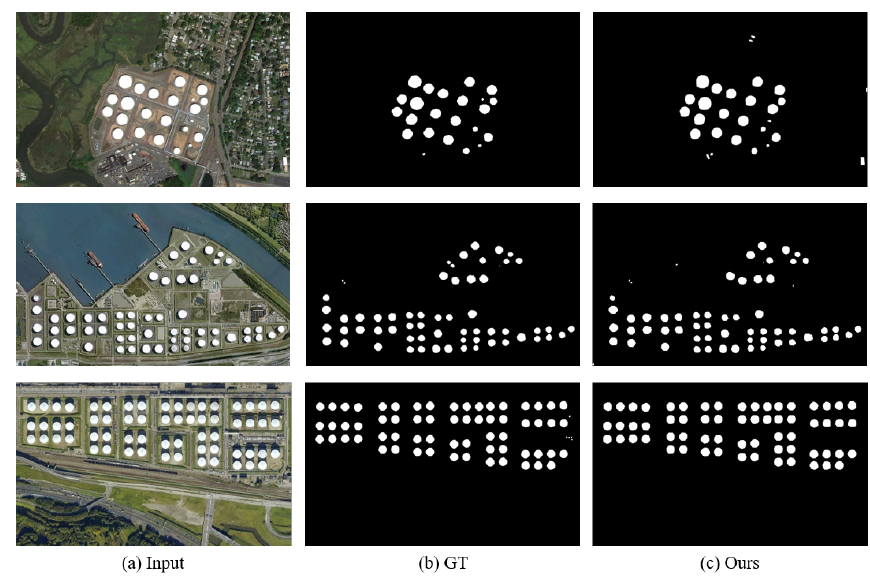
Figure 14. Our methods works in high resolution images. ( a ) is the input image, ( b ) is the ground truth, ( c ) is our